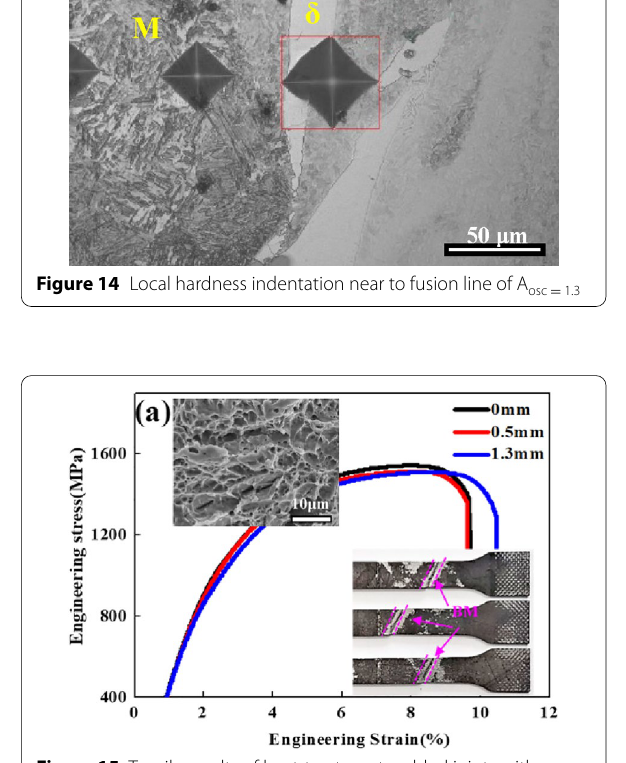
Figure 15 Tensile results of heat-treatment welded joints with different oscillation